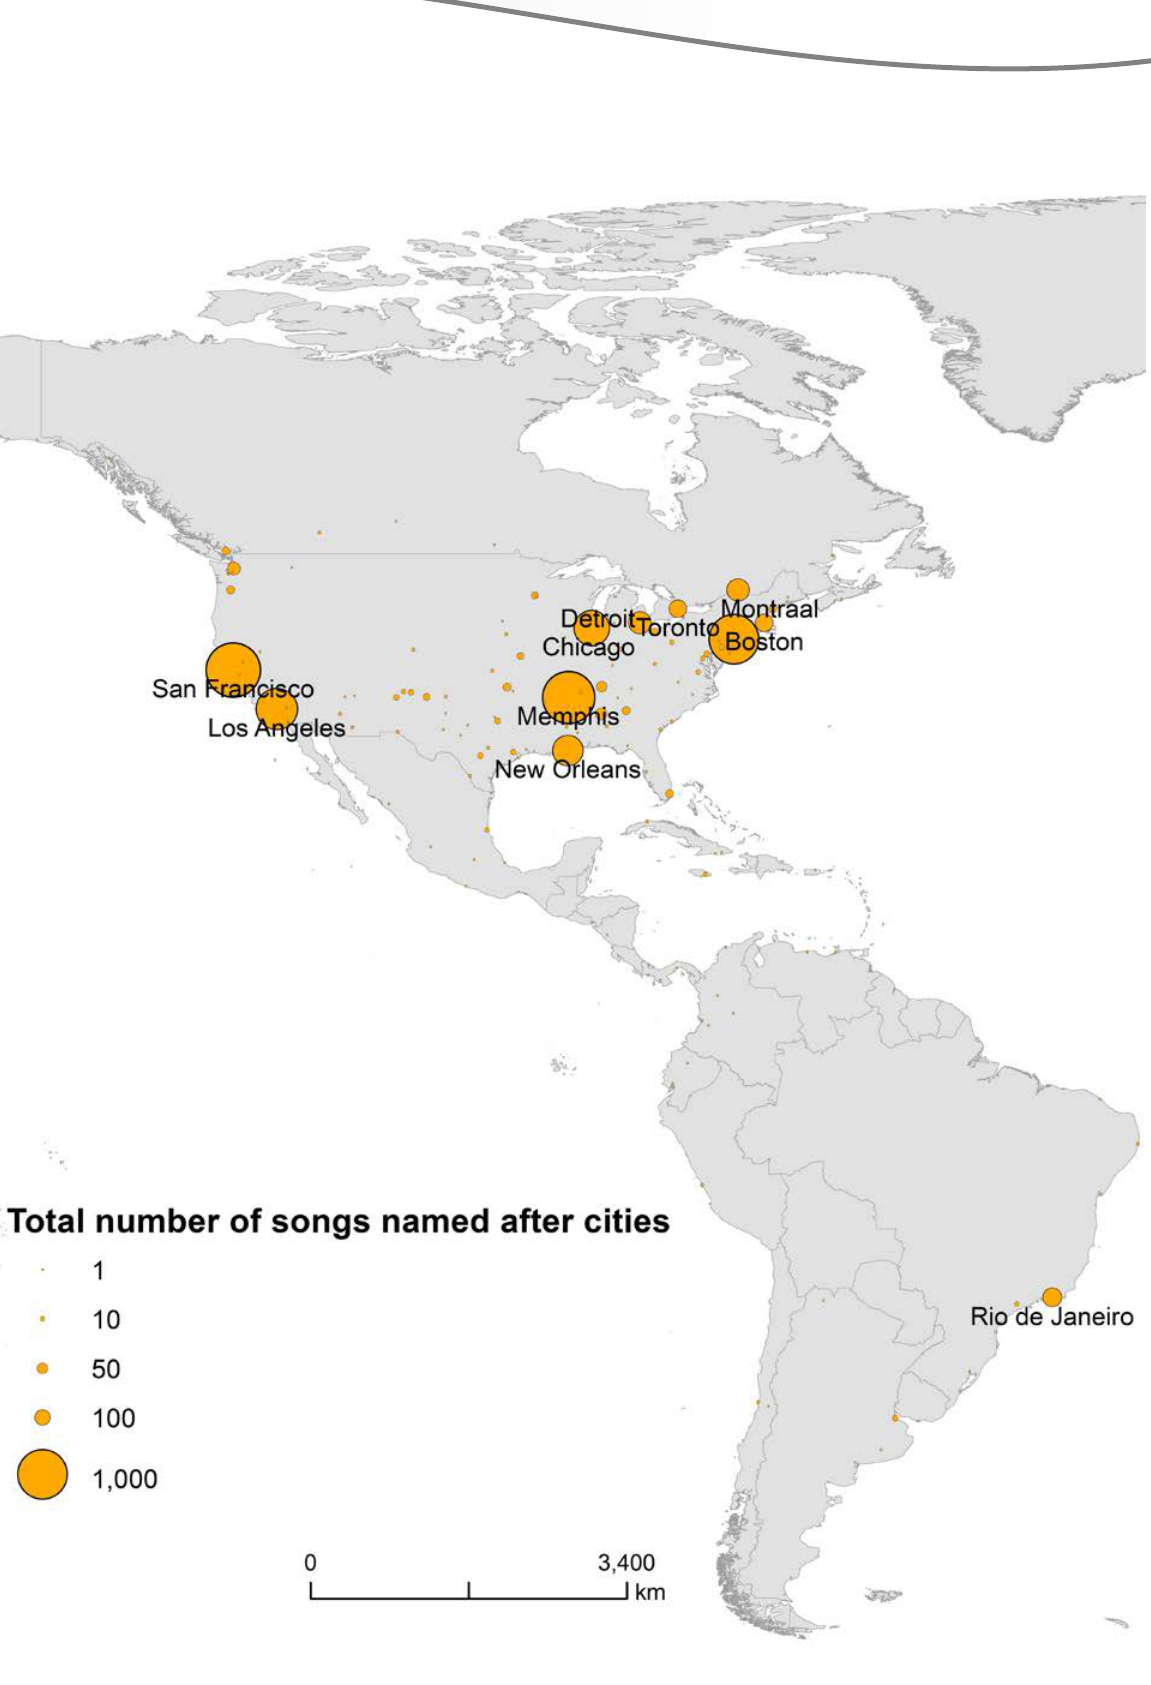
Figure 4: Songs named after cities in America Source: Own map based on JUCU Database